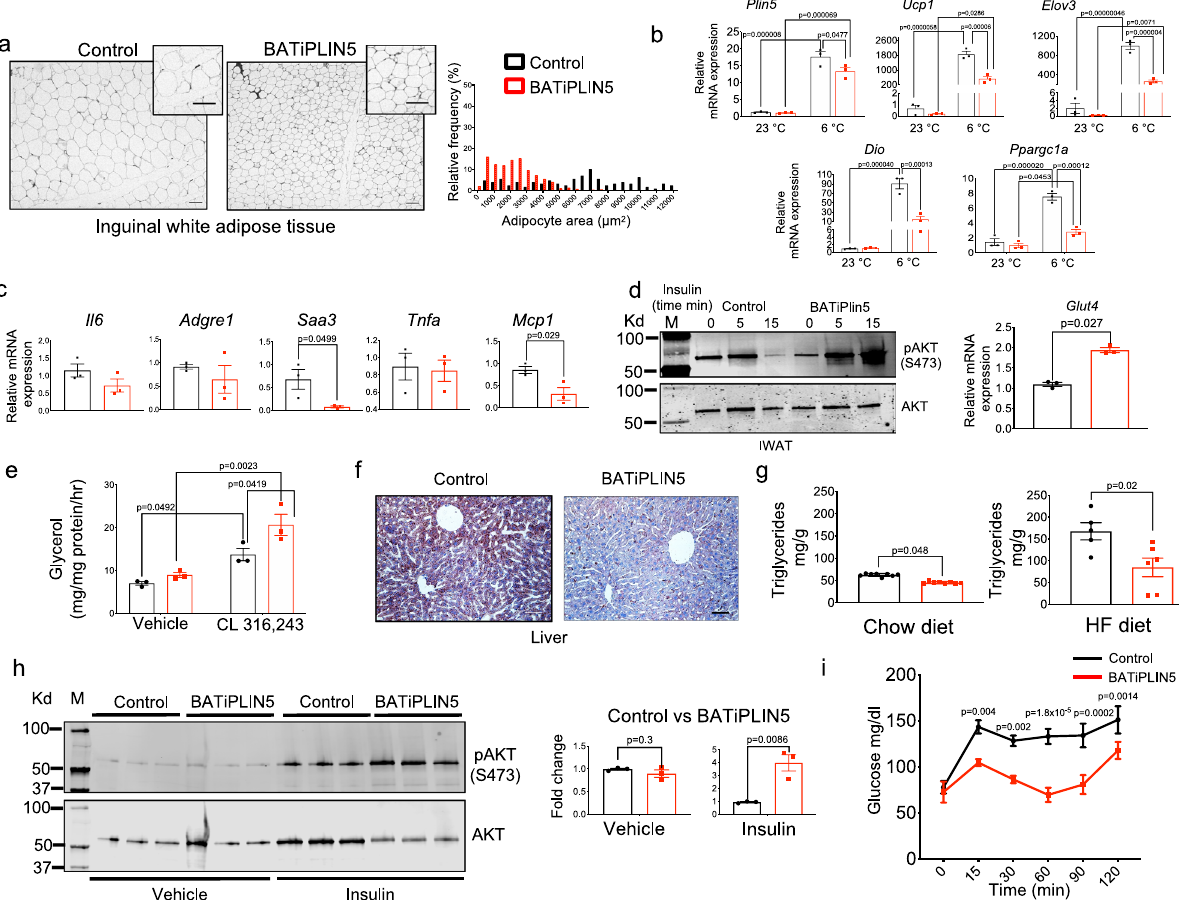
Fig. 5 PLIN5 overexpression in BAT promotes healthy remodeling of iWAT and protects against diet-induced hepatic steatosis. a Representative image of hematoxylin and eosin staining of iWAT from Control or BATiPLIN5 mice housed at 23 °C (left panel) and adipocyte area percentage of frequency distribution (right panel). Scale bar = 100 μ m. b Relative mRNA expression by qPCR for the indicated thermogenic genes in iWAT from Control or BATiPLIN5 mice housed at 23 °C or exposed 6 °C for 16 h. n = 3 mice per group. c Relative mRNA expression qPCR for the indicated genes in iWAT from Control or BATiPLIN5 mice housed at 23 °C. n = 3 mice per group. d Left panel: WB from iWAT harvested from Control or BATiPLIN5 mice blotted for phosphorylated AKT (S473) and total AKT. Right panel: relative mRNA expression of Glut4 ( n = 3 mice per group) by qPCR of iWAT from Control or BATiPLIN5 mice housed at 23 °C. e Ex vivo lipolysis assay (glycerol release) performed on minced iWAT harvested from Control or BATiPLIN5 mice and treated with Vehicle or β 3 adrenergic agonist CL-316,243. n = 3 mice per group. f Representative image of liver Oil red O staining from fasted Control mice or BATiPLIN5 mice fed HF diet for 12 weeks. Scale bar = 100 μ m. g Liver TAG content from BATiPLIN5 or Control mice fed with chow diet (left panel, n = 8 per group) or HF diet (right panel, Control n = 5 and BATiPLIN5 n = 6) for 8 weeks. h WB of liver from Control or BATiPLIN5 mice depicting phosphorylated AKT (S473) and total AKT. Mice were intraperitoneally injected with insulin, and liver was harvested 15 min after insulin injection (left panel) WB quanti fi cation (pAKT/AKT ratio fold change; right panel). i Pyruvate tolerance test performed on Control or BATiPLIN5 mice housed at 23 °C. n = 4 mice per group. Values are mean ± s.e.m. For c , d , g – i , statistical analysis was performed using unpaired two-sided Student ’ s t test. For b and e , statistical analysis was performed using two-way ANOVA followed by Tukey posttest. P values are shown in the fi gure. Source data are provided as a Source data fi